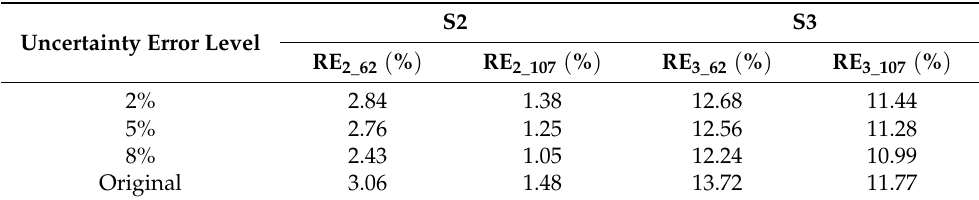
Table 4. Error analysis on the effect of strain measurement